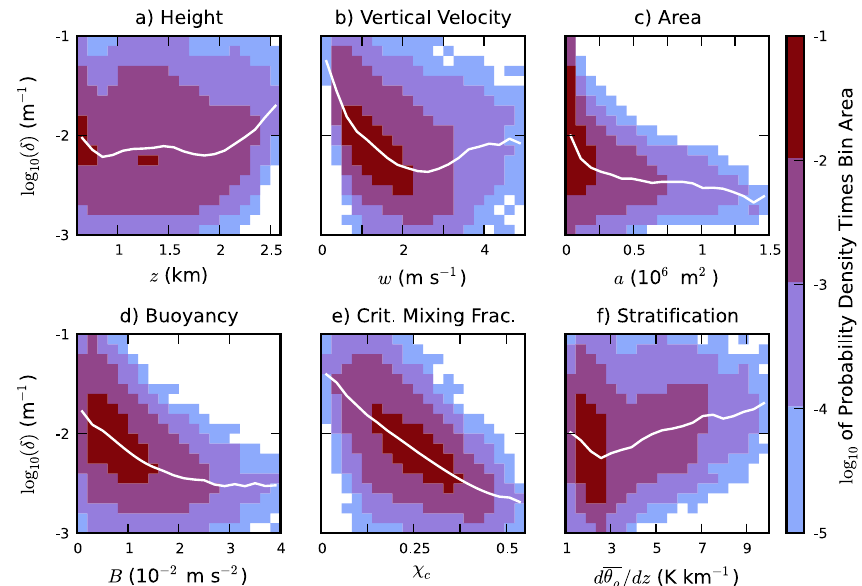
Fig. 7. Joint probability density functions multiplied by bin area ( P(x,y)1x1y ) for individual clouds in the combined BOMEX and ARM LES output of log 10 (δ) versus (a) height, (b) vertical velocity, (c) cross-sectional area, (d) buoyancy, (e) critical mixing fraction, and (f) vertical gradient of environmental density potential temperature. PDFs are plotted using a logarithmic scale. White lines indicate the mean log 10 (δ) value as a function of the x axis